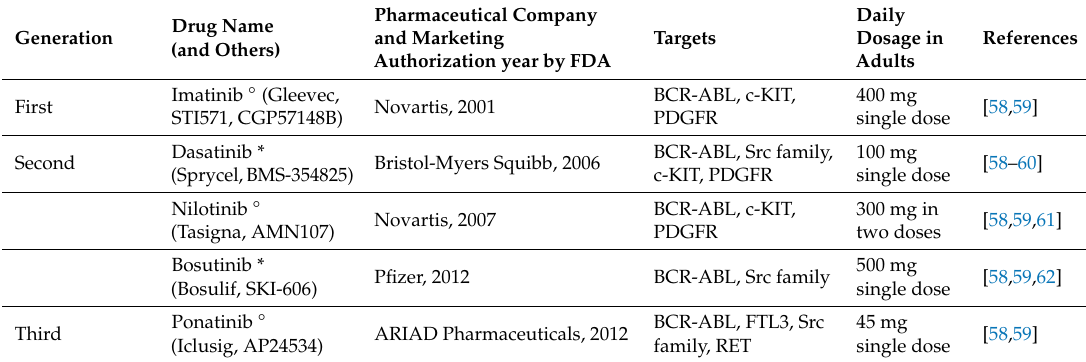
Table 3. Tyrosine kinase inhibitors approved by the US Food and Drug Administration for the treatment of chronic myeloid